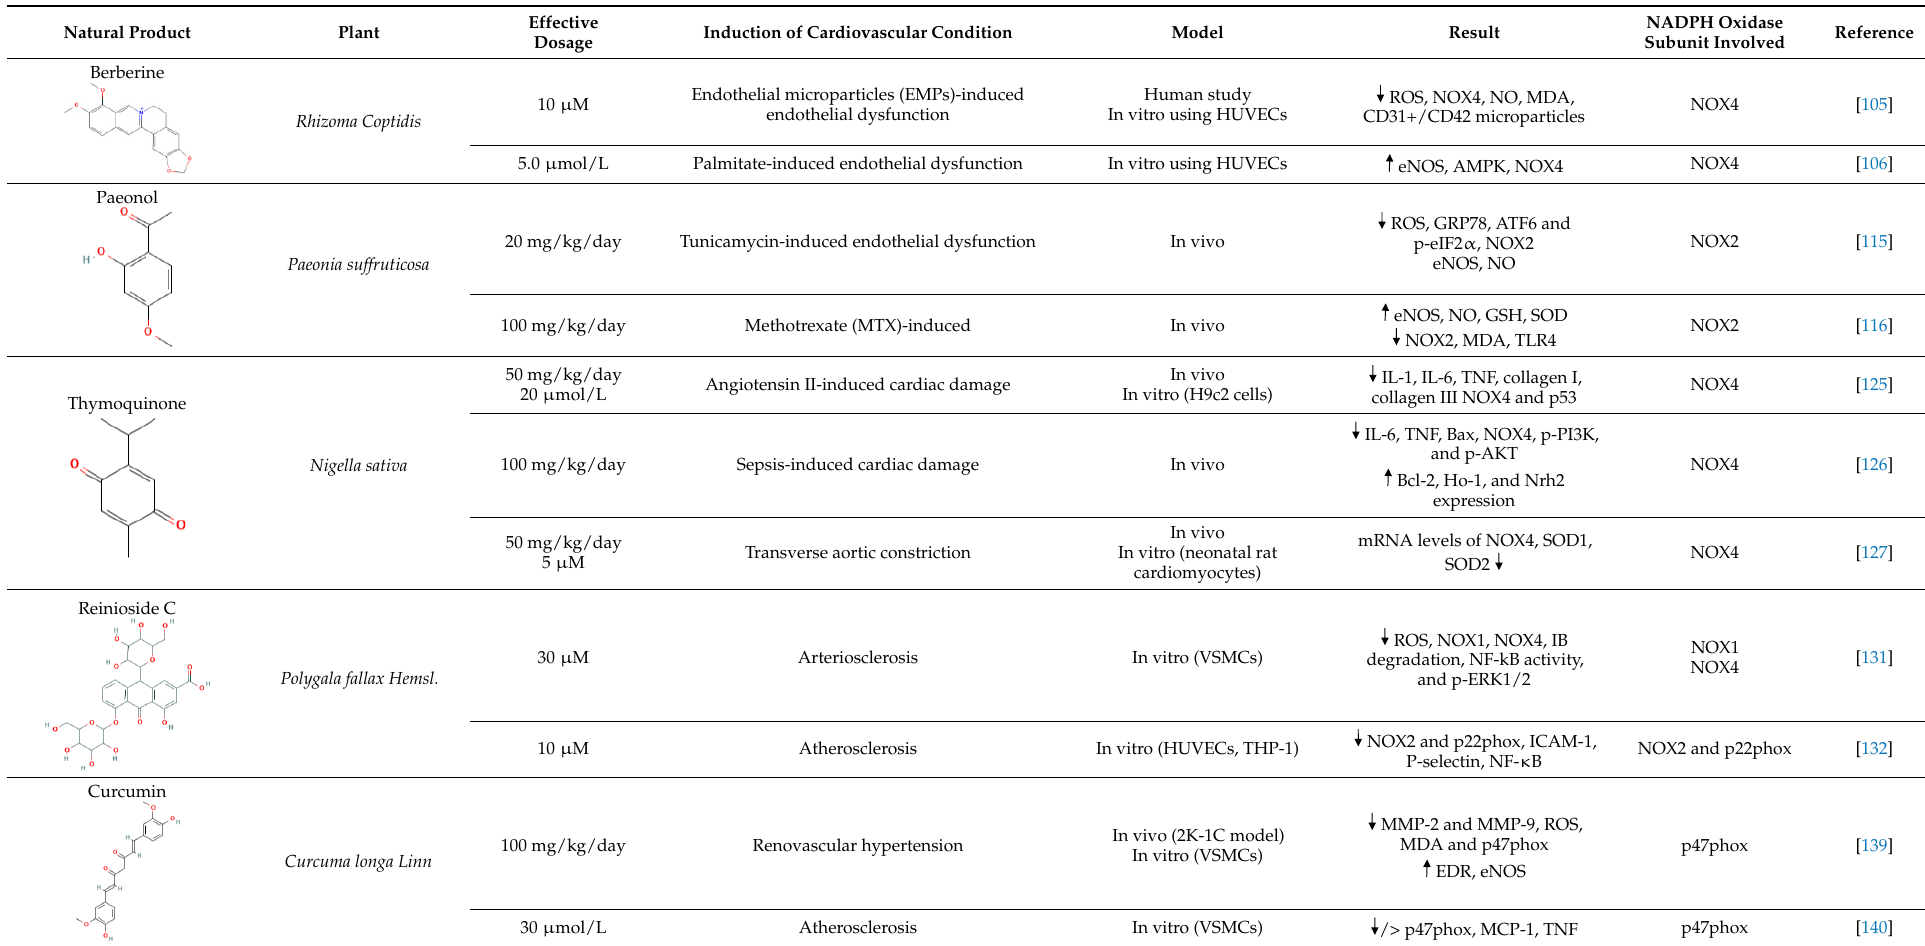
Table 2. List of natural products that target the NADPH oxidase pathway in CVD. The arrow indicate down-regulation and indicate up-regulation of the markers.